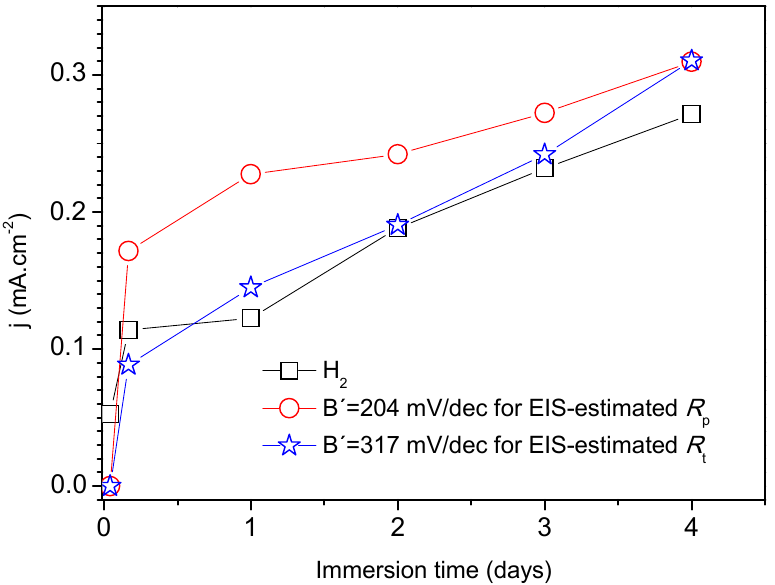
Figure 8. Variation in corrosion current density (mA cm − 2 ) as a function of immersion time, obtained from EIS and hydrogen evolution measurements during immersion of AZ31B alloy in the Ringer’s solution for 4 days (37 °C).